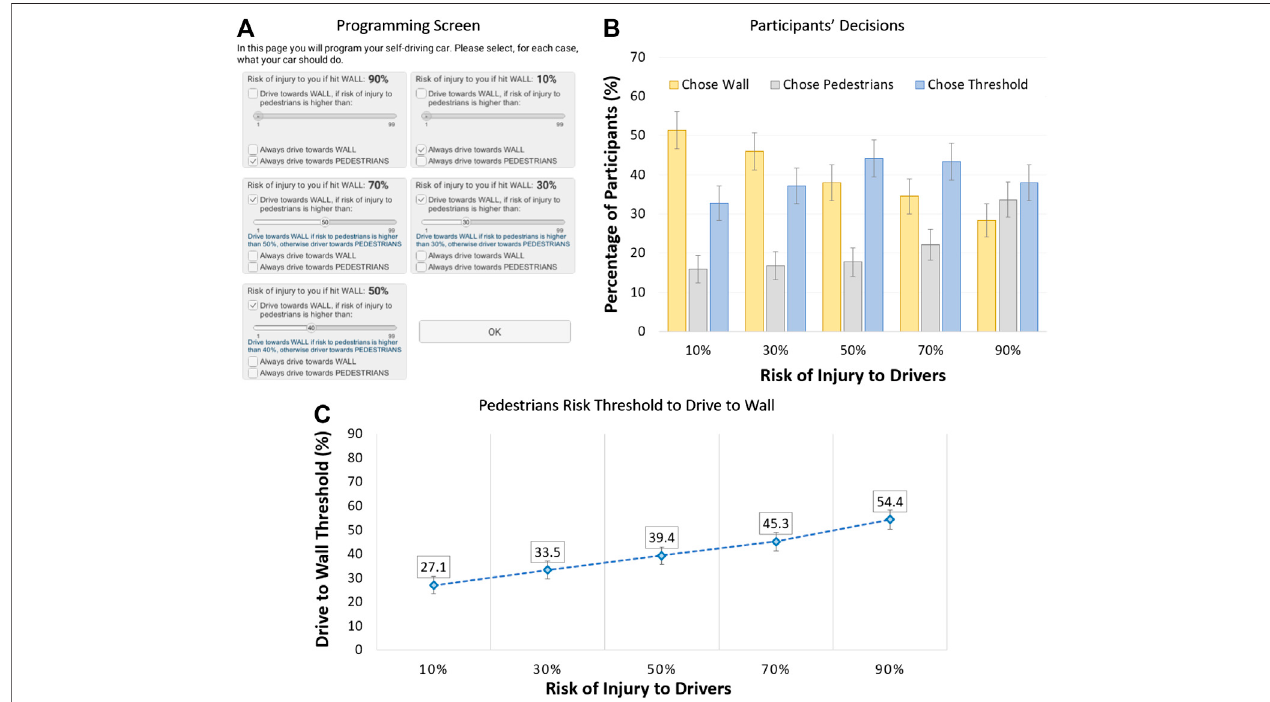
FIGURE 4 | Moral dilemma software and results in Experiment 3: (A) programming interface; (B) percentage of participants that always chose wall, always chose pedestrians,orchosetospecifyaswitchthreshold; (C) thresholdforpedestriansriskatwhichparticipantsswitchtoutilitarianchoice,forvariouslevelsofrisktothedriver (error bars show standard